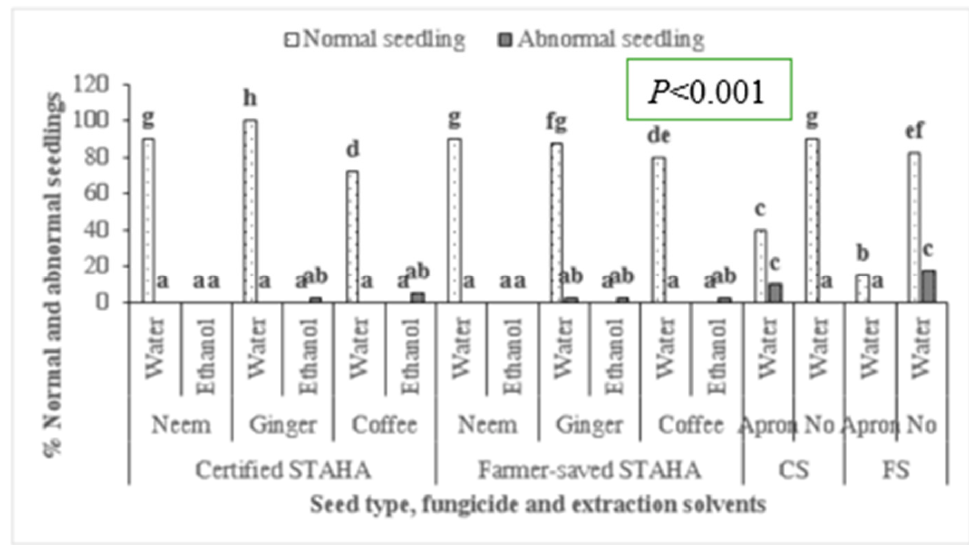
Figure 8. Effects of a three-way interaction between seed types, fungicides, and extraction solvents on percentages of normal and abnormal seedlings. Means with the same letters along the same bars are not significantly different ( p < 0.05).